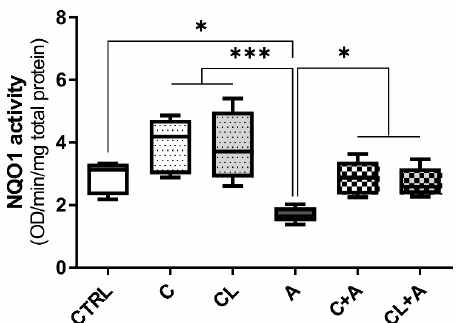
Figure 8. NQO1 enzyme activity. Box and whiskers plot reporting the NQO1 activity in the different experimental conditions. The median NQO1 activity in cells exposed to AFB1 was compared to the activity observed in all the other experimental conditions. Data are obtained from six independent cell culture experiments and expressed as median optical density (OD) observed per min per mg of total protein. CTRL condition corresponds to cells exposed to PCB126 only. C = curcumin; CL = Curcuma longa ; A = AFB1. * p ≤ 0.05; *** p ≤ 0.001 (one-way ANOVA, followed by Dunnett’s multicomparisons test).